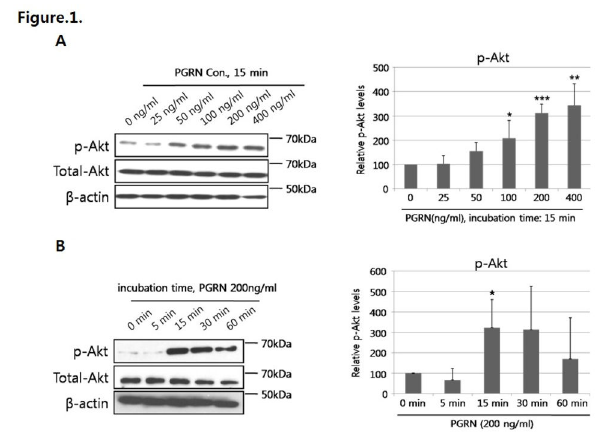
1. Progranulin (PGRN) induced Akt phosphorylation in HUVECs. (A) Cells were stimulated with various doses of progrnaulin (0, 25, 50, 100, 200, or 400 ng/mL) for 15 min and analyzed by Western blotting for phosphorylated-Akt (p-Akt) level. (B) HUVECs were incubated with 200 ng/mL of progranulin for the indicated times (0, 5, 15, 30, or 60 min). Data were obtained from three separate experiments. Error bars represent mean ± SD (*, P < 0.05, t -